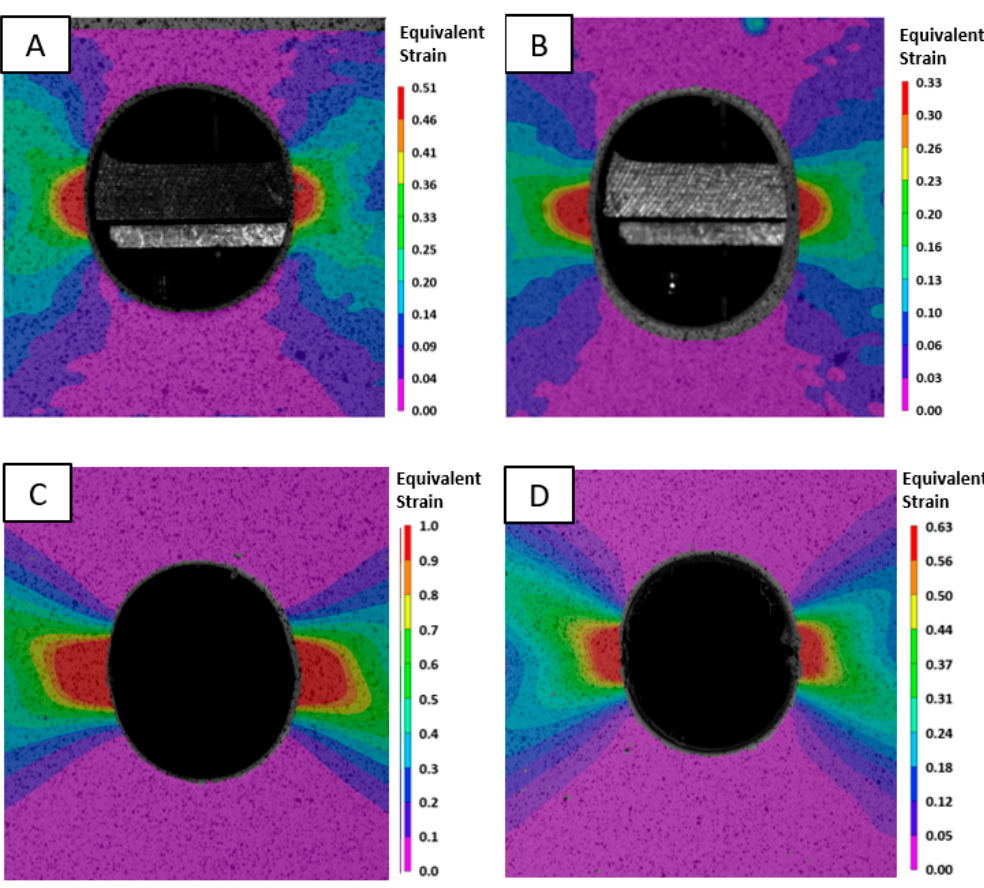
Figure 7. Contour plot of equivalent strain during the hole tension test of the ( A ) DP780 reamed edge; ( B ) DP780 sheared edge; ( C ) CP800 reamed edge; and ( D ) CP800 sheared edge.